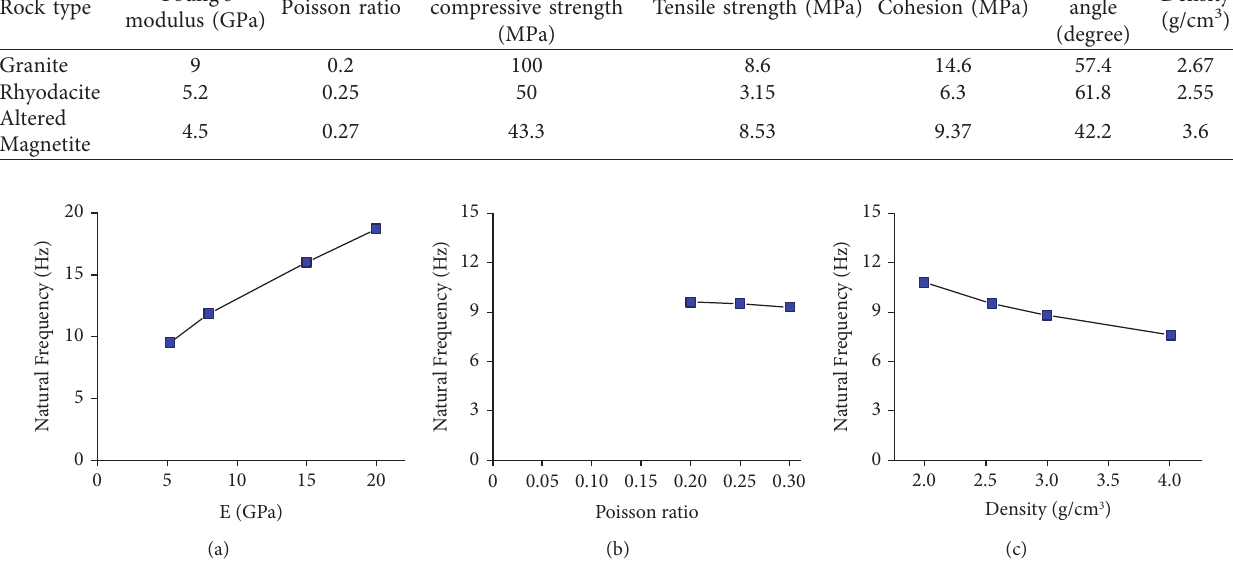
Figure 9: Natural frequency variation versus (a) deformation modulus, (b) Poisson ration, and (c) density. Table 3: Specifications of different explosives used in modeling [34, 35].